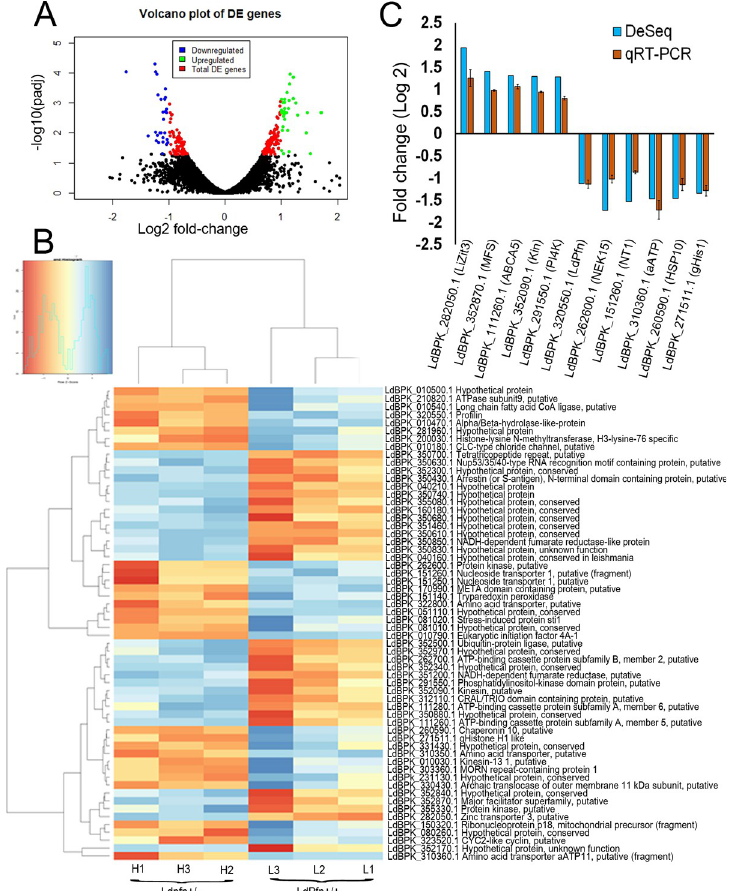
Fig 2. Differentially expressed genes. (A) Volcano plot of differentially expressed genes. The x-axis represents the log 2-fold change and y-axis represent -log10 (adj P-value). Green dots represent up-regulated genes, blue dots represent down-regulated genes and red dots represent other differentially expressed genes. (B) Heatmap of top 30 up-regulated and down-regulated genes following hierarchical clustering analysis. L1, L2, L3 are the three replicates of controls (LdPfn+/+), and H1, H2, H3 are the three replicates of single knockout samples (LdPfn+/-). The horizontal axis represents the samples, and the vertical axis represents the differentially expressed genes (DEGs). Red indicates down- regulated genes and blue indicates up- regulated genes in LdPfn+/- cells. (C) Comparative analysis of the relative expression levels of selected transcripts determined by RNA-Seq and validated by RT-qPCR. Based on the RNA-Seq (DeSeq) analysis, five up-regulated transcripts: LdBPK_282050.1.1 (Zinc transporter 3, putative), LdBPK_352870.1.1 (major facilitator superfamily, putative), LdBPK_111260.1.1 (ATP-binding cassette protein subfamily A, member 5, putative), LdBPK_352090.1.1 (kinesin, putative), LdBPK_291550.1.1 (phosphatidylinositol-kinase domain protein. putative) and five down-regulated transcripts: LdBPK_262600.1.1 (protein kinase, putative), LdBPK_151260.1.1 (nucleoside transporter 1, putative (fragment)), LdBPK_310360.1.1 (amino acid transporter aATP11, putative (fragment)), LdBPK_260590.1.1 (Chaperonin 10, putative), LdBPK_271511.1.1 (g histone H1 like) and LdBPK_320550.1.1 (profilin) were selected for validation by RT-qPCR. The RT-qPCR experiments were conducted at least three times and the results are expressed as mean ±